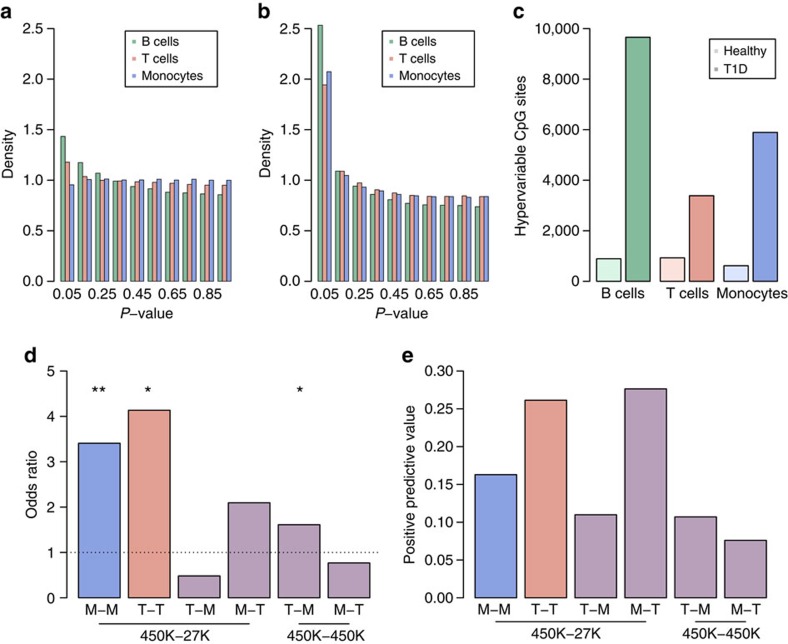
DNA methylation variation in identical twin pairs discordant for T1D.(a) Histogram of P-values for the identification of differentially methylated CpG positions (DMPs) between T1D-discordant MZ twin pairs in different immune effector cell types. DMPs were determined using a paired t test. (b) Histogram of P-values for the identification of T1D-associated differentially variable CpG positions (DVPs). DVPs were determined at an FDR of <0.001 using the algorithm iEVORA. (c) Bar plots showing the enrichment of DVPs in T1D twins compared with their healthy co-twins. While this hypervariability phenotype was found in all cell types (P<1 × 10−100, binomial test), it was particularly pronounced in B cells. (d) Bar plots showing the odds ratios of the assessment of temporal stability of T1D-associated DVPs in an external data set of CD14+ and CD4+ cells derived from 12 disease-discordant MZ twin pairs generated on 27K arrays. Importantly, the identified DVPs in CD14+ and CD4+ cells replicated in a cell type-specific context. Stars denote statistical significance assessed using a one-tailed Fisher's exact test: *P<1 × 10−2 and **P<1 × 10−4. (e) Positive predictive values for the analyses shown in d. B, CD19+ B cells; M, CD14+CD16− monocytes; T, CD4+ T cells.